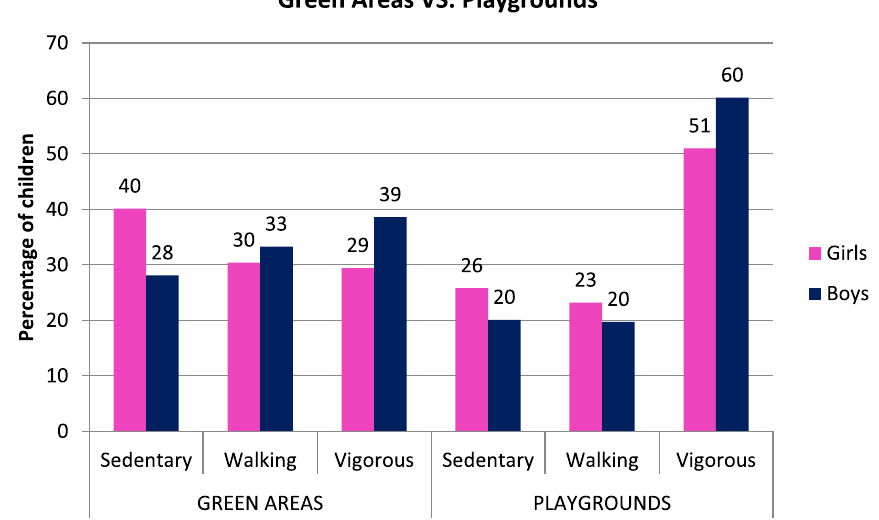
Fig. 2 Children’s physical activity levels in green areas and